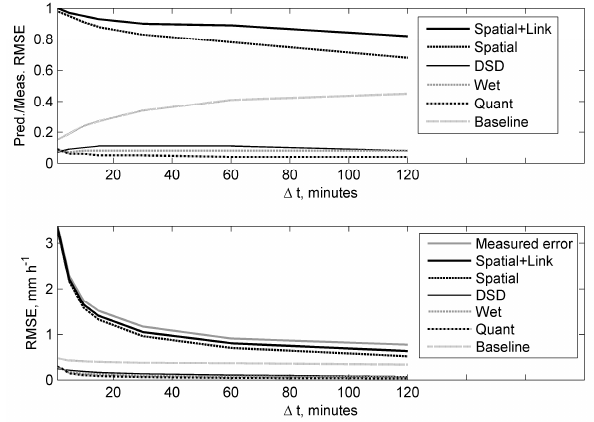
Fig. 9. Performance statistics ¯ S (top), measured ¯ e and predicted accumulated errors ¯ p (Eq. 51) for various error sources (bottom), Figure 9. Performance statistics S (top), measured e and predicted accumulated errors p 3 as a function of temporal averaging (Eq. 51) for various error sources (bottom), as a function of temporal averaging interval. 4